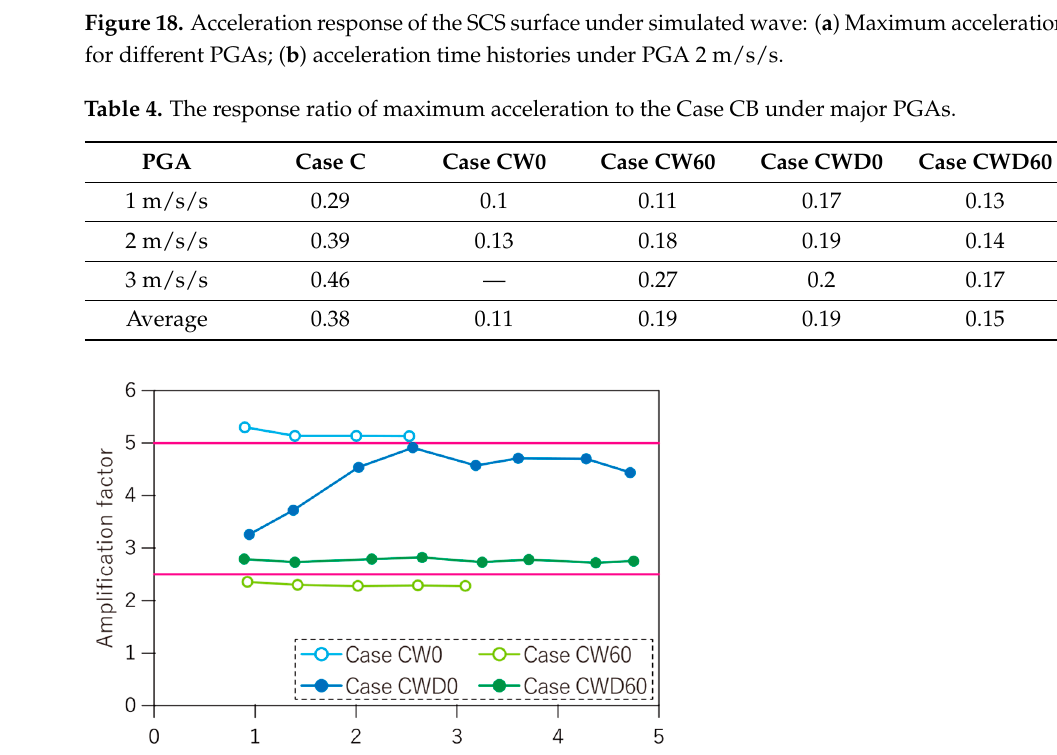
Figure 18. Acceleration response of the SCS surface under simulated wave: ( a ) Maximum accelera- tion for different PGAs; ( b ) acceleration time histories under PGA 2 m/s/s. Table 4. The response ratio of maximum acceleration to the Case CB under major PGAs.